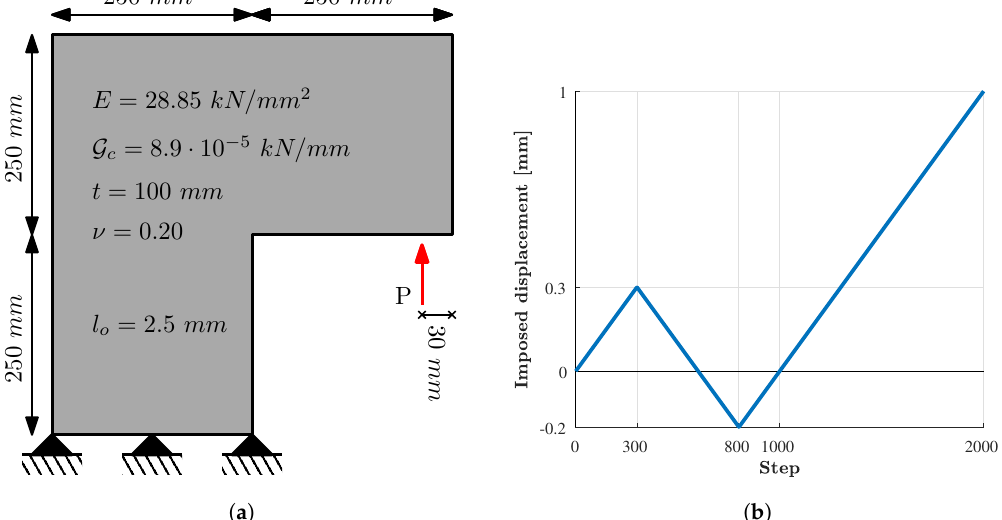
Figure 31. ( a ) LSP geometry, material parameters, loading and boundary conditions ( b ) Cyclic envelope of monitored displacement.